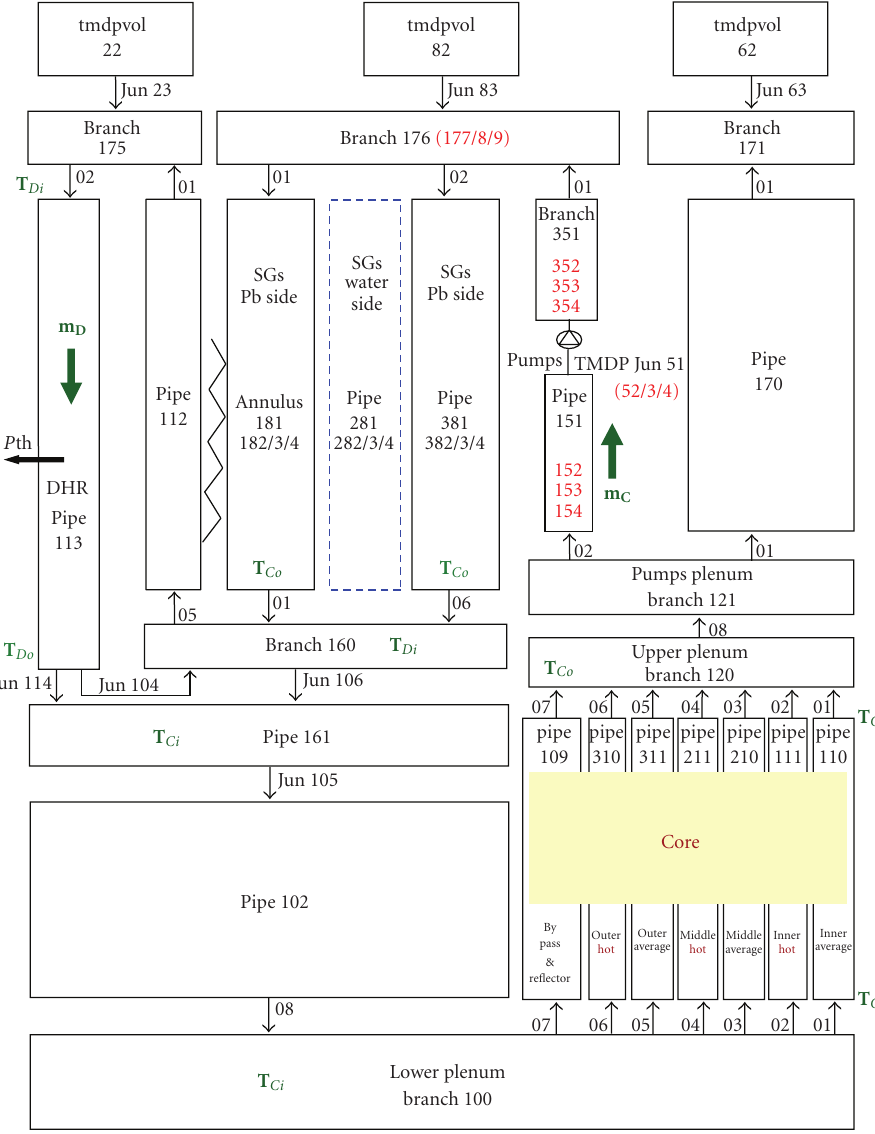
Figure 5: RELAP5 nodalization scheme of EFIT